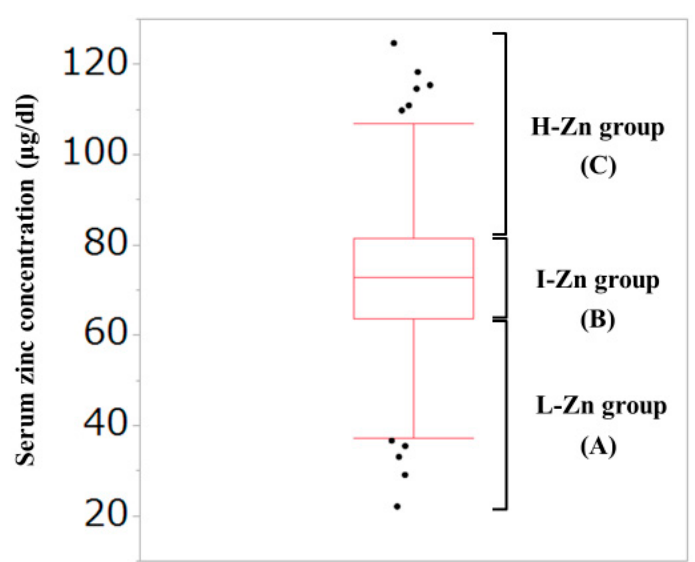
Figure 1. Our classification based on the serum Zn concentration. The median (interquartile range) serum Zn concentration for all cases in the current analysis was 72.85 (63.7, 81.45) µ g/dL. ( A ) Low-Zn group; patients with serum Zn concentration <63.7 µ g/dL (first quartile). ( B ) Intermediate-Zn group; patients with 63.7 µ g/dL <serum Zn concentration <81.45 µ g/dL (second or third quartile). ( C ) High-Zn group; patients with serum Zn concentration >81.45 µ g/dL (fourth